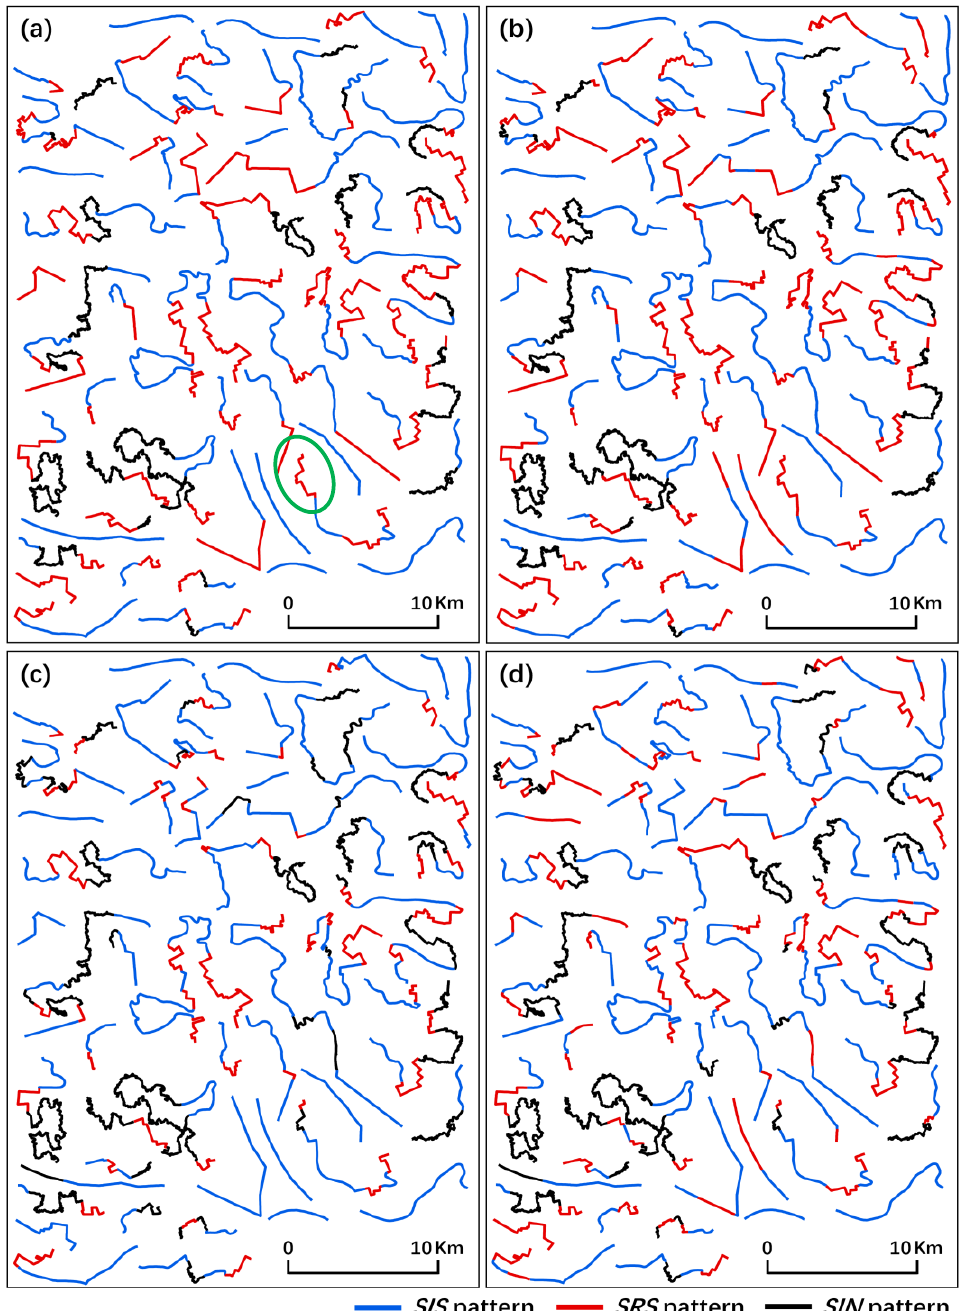
Figure 12. Segmentation results for the test administrative boundaries: ( a ) manual segmentation, ( b ) 1D-U-Net method, ( c ) BANN method, and ( d ) NB method.